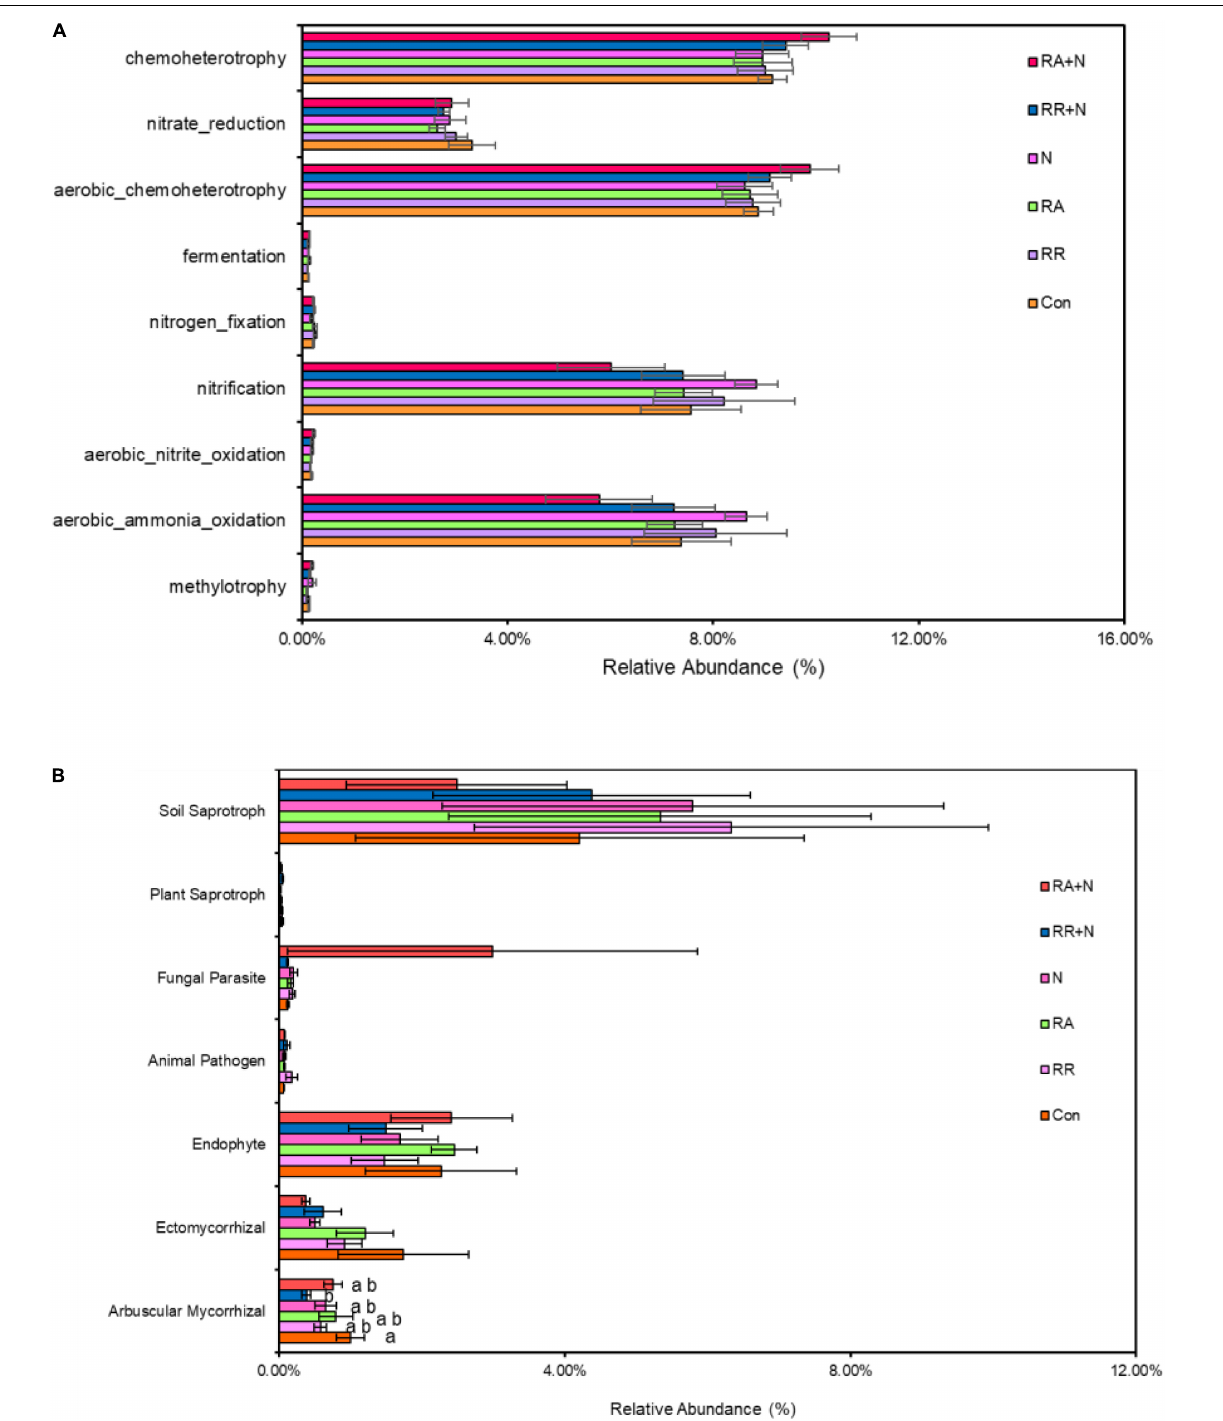
FIGURE 5 | The effects of altered nitrogen addition and rainfall, and their interaction, on the relative abundance of bacterial (A) and fungal (B) functional groups based on the FAPROTAX tool and FUNGuild pipeline, respectively. Different treatments: Con: Control; RR: Rainfall reduction; RA: Rainfall addition; N: Nitrogen addition; RR + N: Rainfall reduction and Nitrogen addition; RA + N: Rainfall addition and Nitrogen addition. Values are mean ± SE ( n = 5). Different lowercase letters indicate the significant differences ( p < 0.05) according to Duncan’s post hoc test. Different lowercase letters indicate significant differences ( p < 0.05) according to Duncan’s post hoc